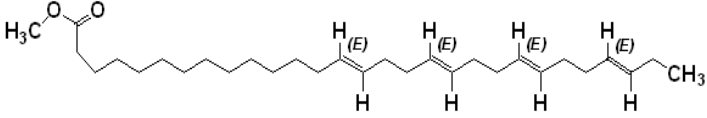
Figure 1. Structure of the fatty acid isolated from the chloroform fraction of Amaranthus spinosus